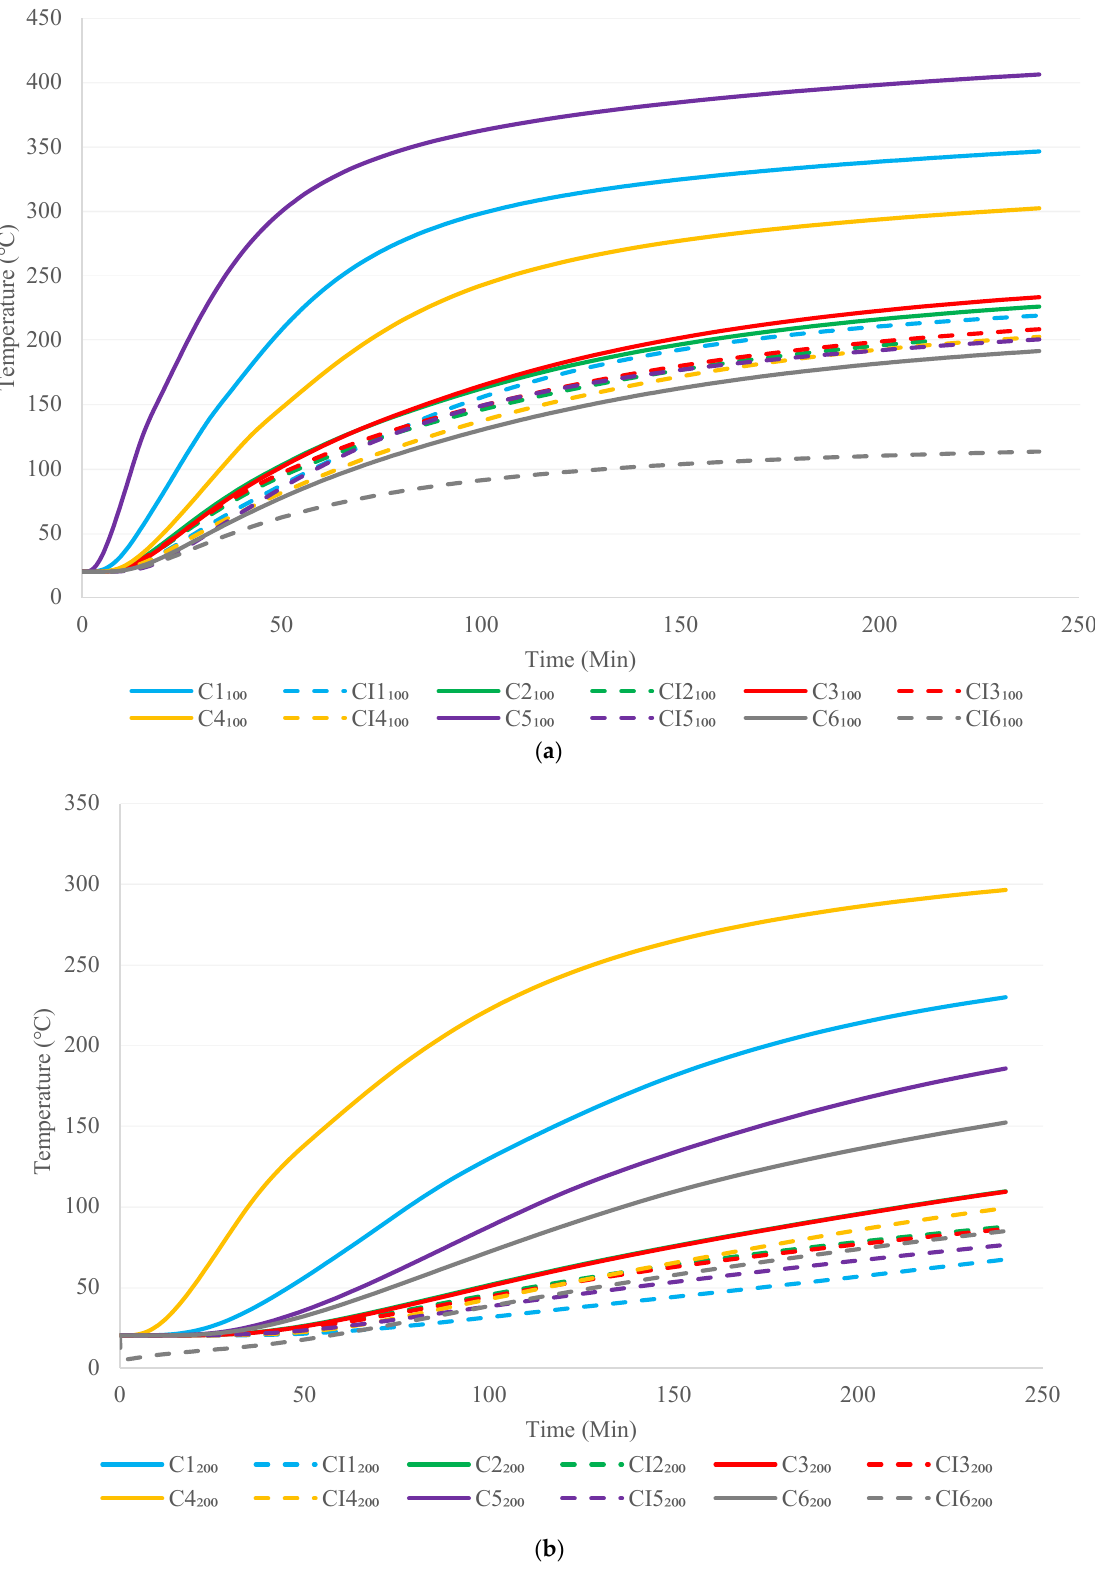
Figure 9. ( a ) Unexposed surface temperature variation of 100 mm wall configurations subjected to standard fire. ( b ) Unexposed surface temperature variation of 200 mm wall configurations subjected to standard fire.